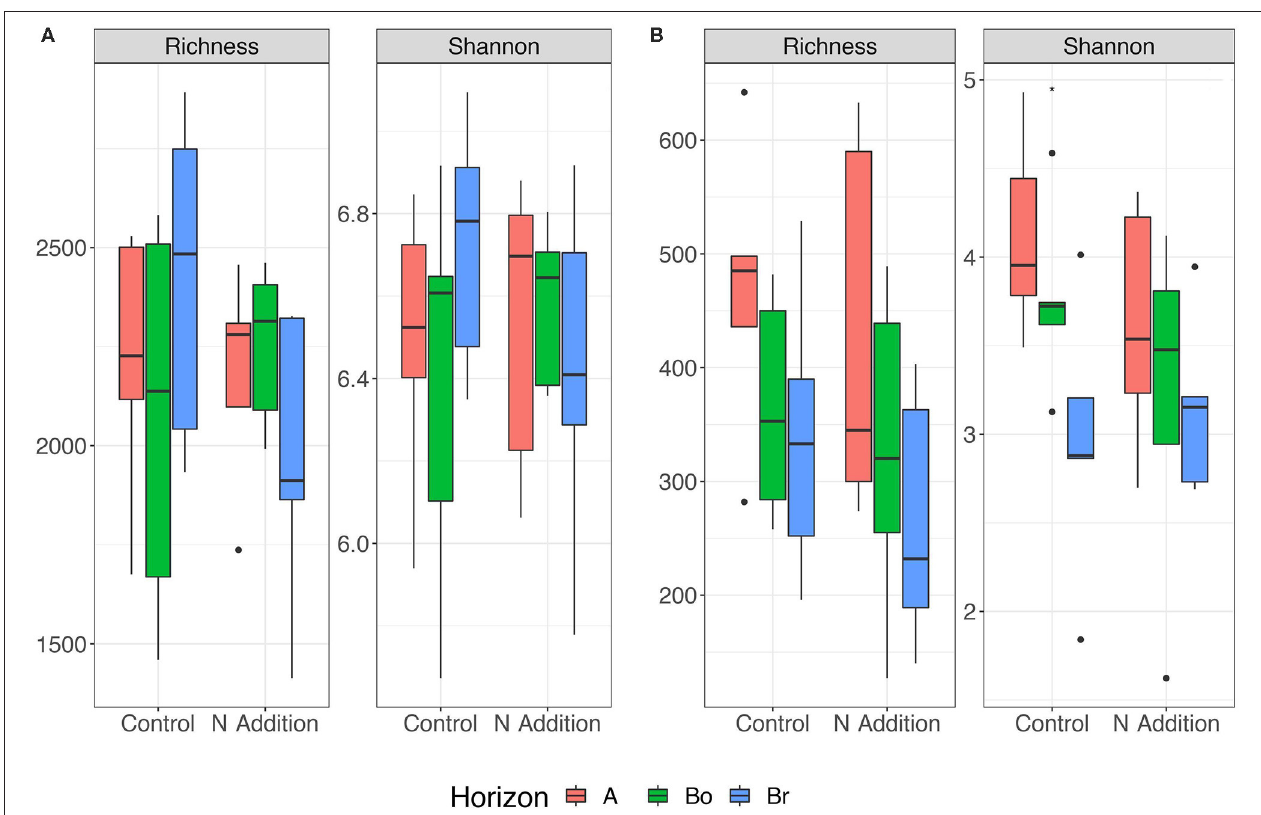
FIGURE 3 | Variation in Richness and Shannon index of bacterial (A) and fungal (B) communities in the horizons of the mineral soil in the control and N-addition plots ( n = 5; A, A horizon; Bo, oxic B horizon; Br, reduced B horizon).